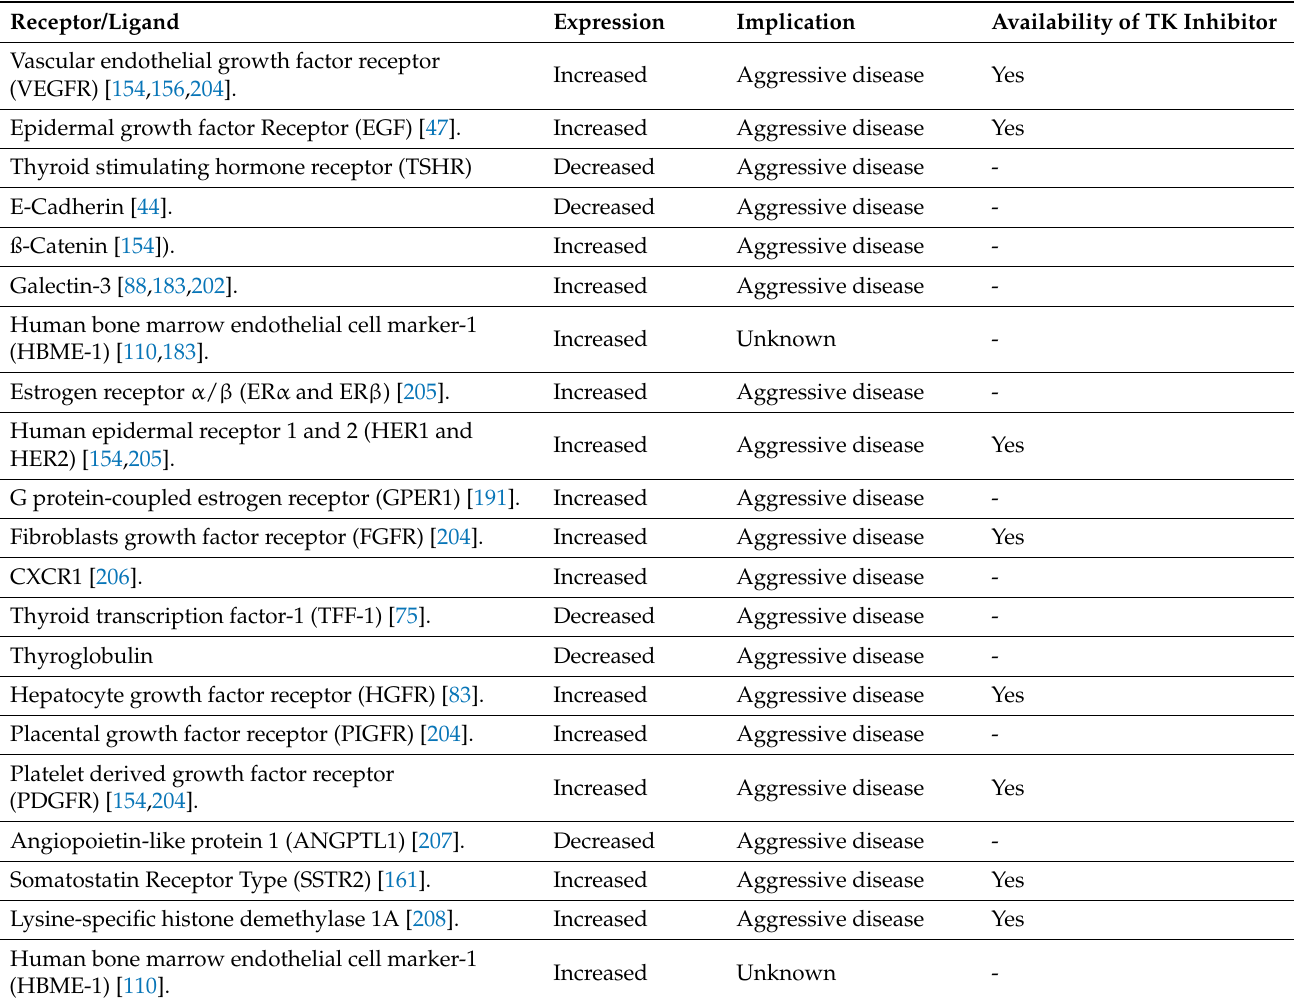
Table 3. A list of transmembrane receptors, including their ligands, whose expression is altered and plays a role in the tumorigenesis and progression of FTC and other